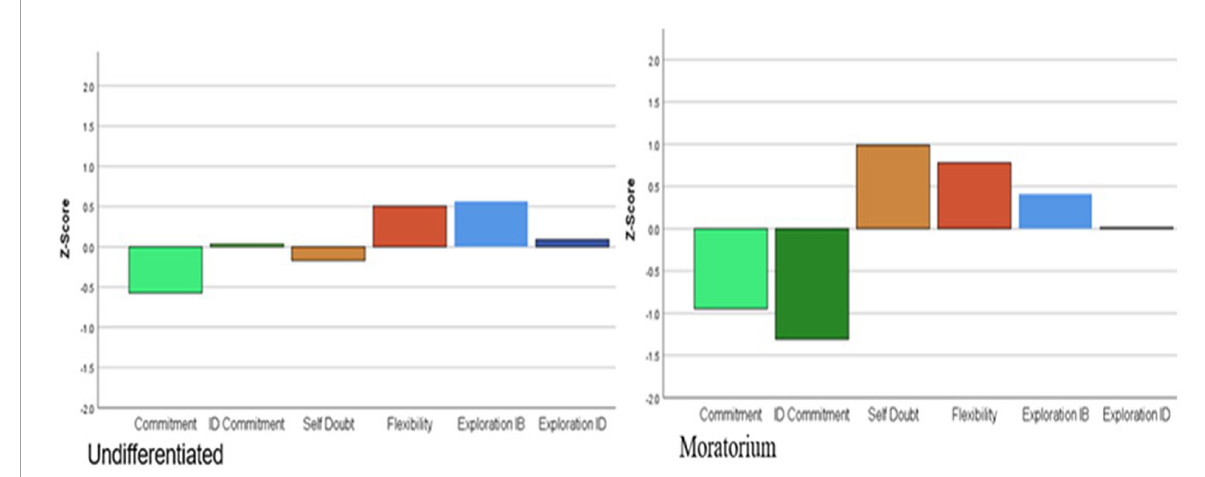
FIGURE4 Profiles for moderate (undifferentiated and moratorium) identity statuses.